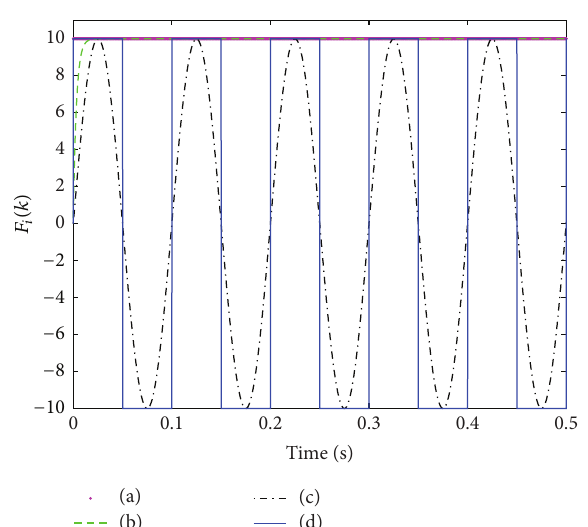
Figure 7: Four-control input signal.